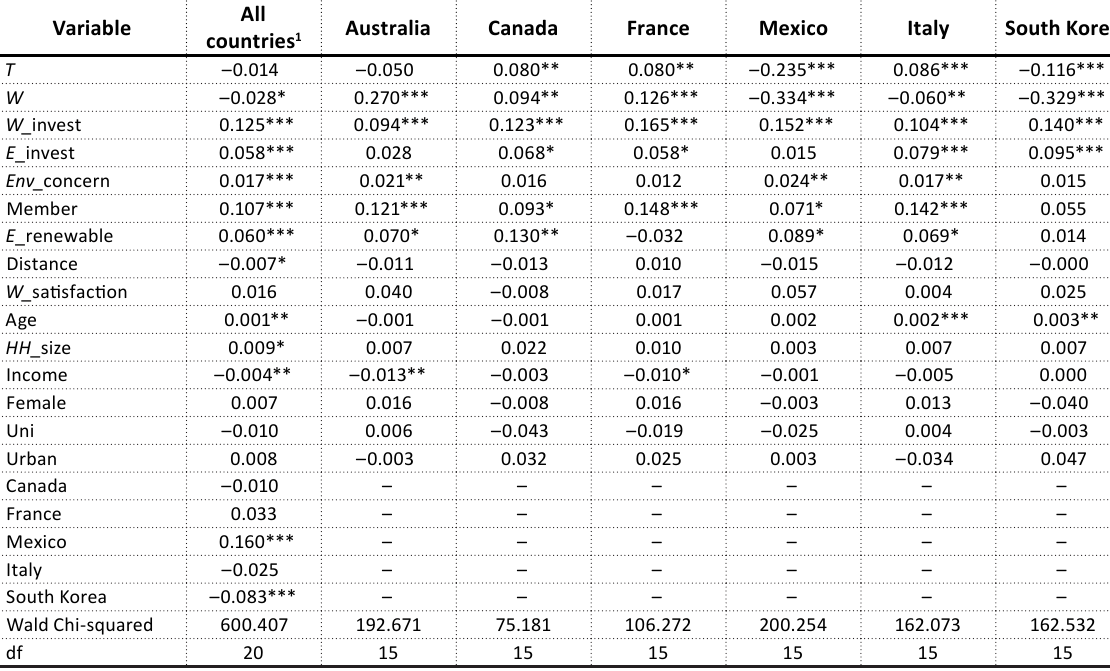
Table B2. Average discrete effects of binary probit, dependent variable in model: engagement in